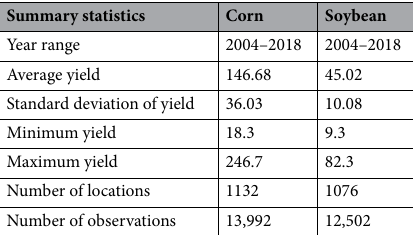
Figure 2. The map of US Corn Belt. Summary